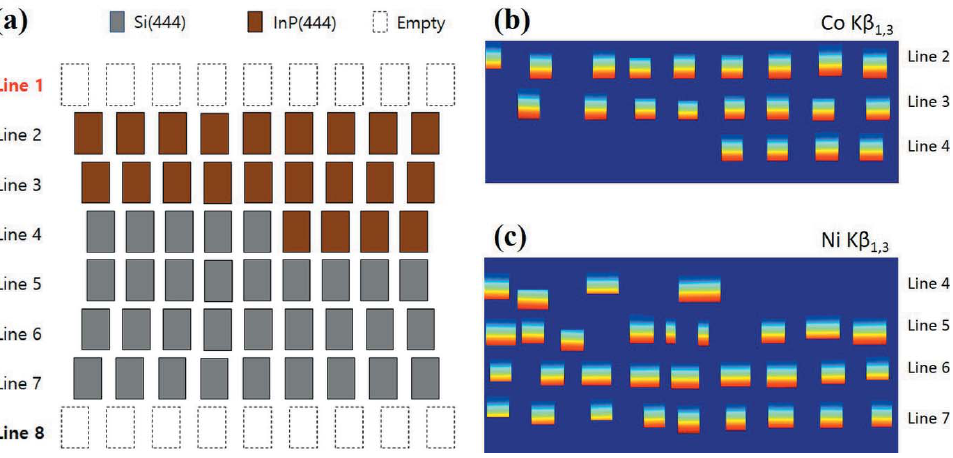
Figure 8 ( a ) Schematic of the spectrometer for multiple-edge measurement. Spectrometers are designed to accommodate up to 72 analyzers. Si(444) and InP(444) analyzers correspond to the energy range of Ni K (cid:2) 1,3 and Co K (cid:2) 1,3 , respectively. ( b ) CEM for Co K (cid:2) 1,3 . ( c ) CEM for Ni K (cid:2) 1,3